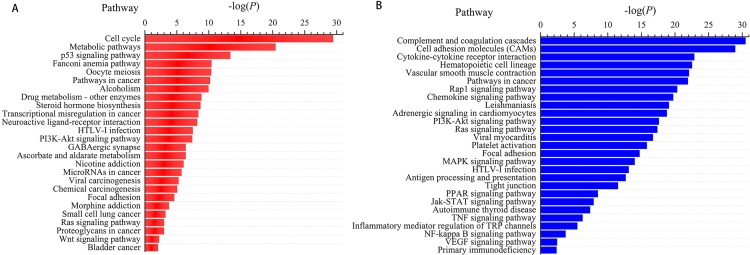
Pathways enrichment analysis for LUSC groups versus controls (the bar plot shows the enrichment scores of the significant enrichment pathways).(A) Key pathways in upregulated, differentially expressed genes; (B) key pathways in downregulated, differentially expressed genes.